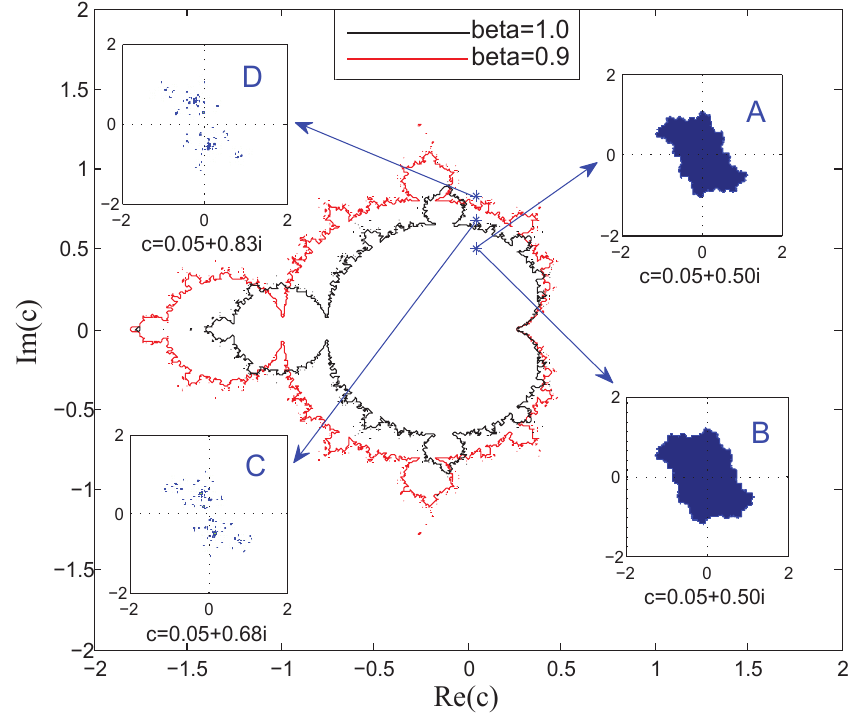
Figure 2. M ( P c ) , classical Mandelbrot set and ( A ) Connected Julia set, ( B ) Connected superior Julia set, ( C ) Totally disconnected Julia set, and ( D ) Totally disconnected superior Julia